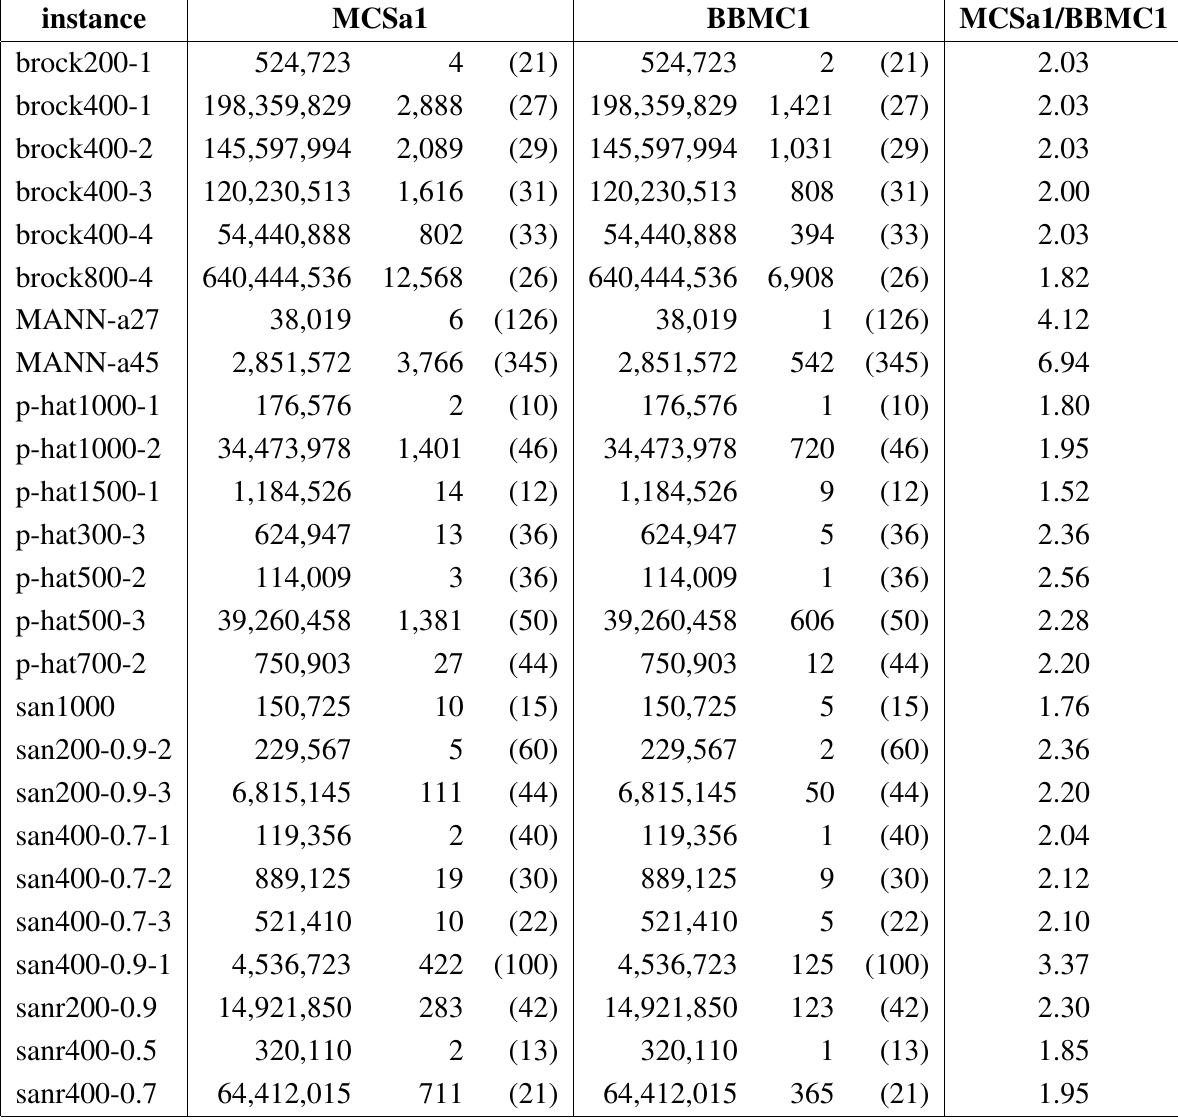
Table 2. DIMACS Goldilocks instances: MCSa1 vs. BBMC1, nodes, run time in seconds and clique